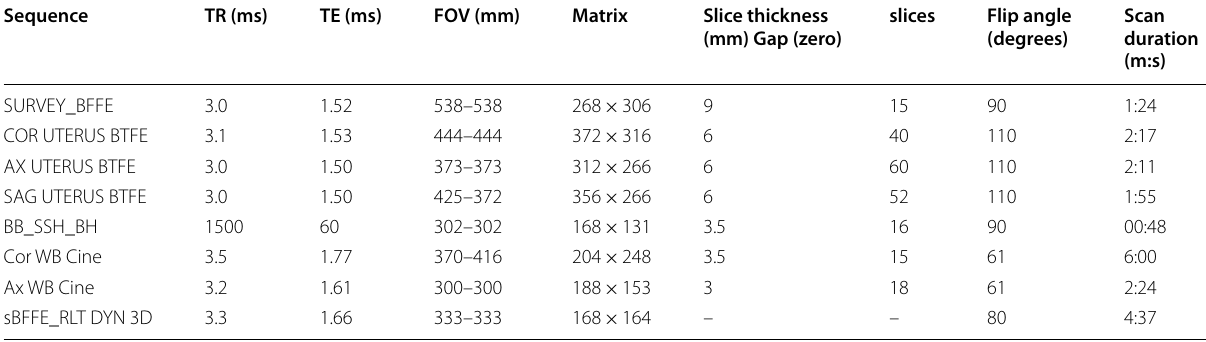
Table 1 Detailed parameters of each FCMR imaging sequences: Sequence TR